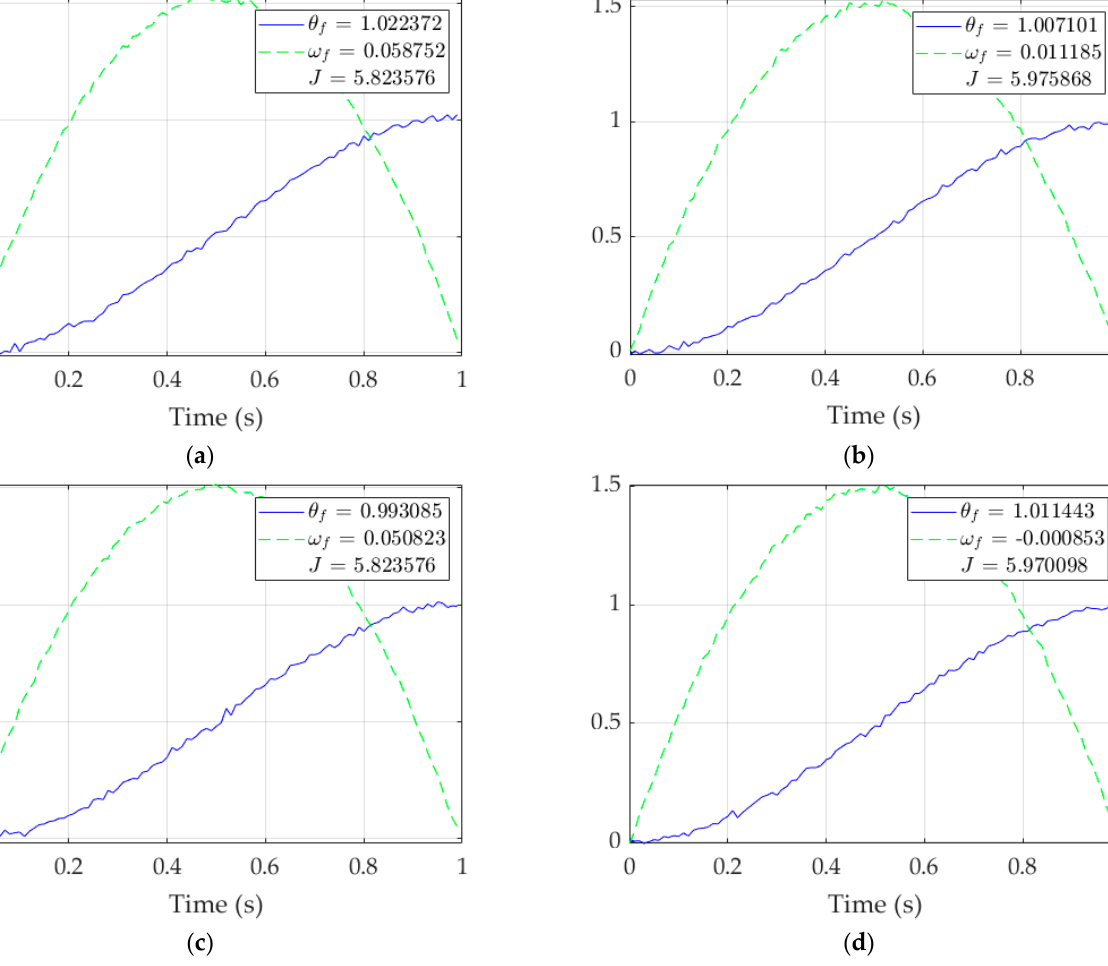
Figure 6. Singular runs of RTOC for each matrix inverse procedure. Solid blue line : θ ( t ) ; dashed green line : ω ( t ) . ( a ) ( A ) − 1 ; ( b ) 1 \ A; ( c ) inv( A ); ( d ) pinv( A ). Note the failure of plots ( a , c ) to reach the right side, where time = 1 s.